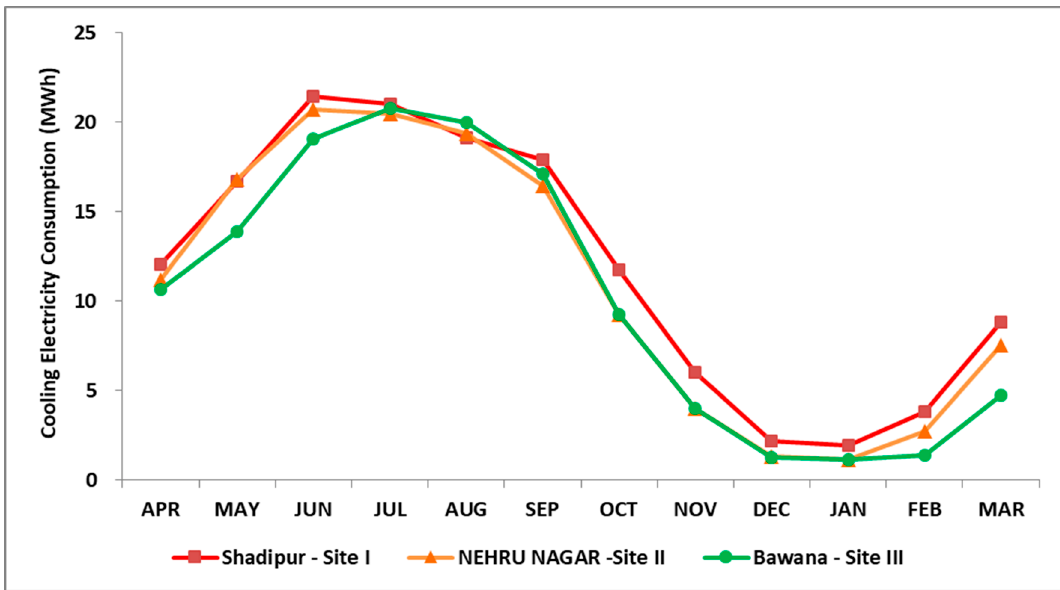
Figure 8. Total cooling load of building in three di ff erent thermal regimes of LST of